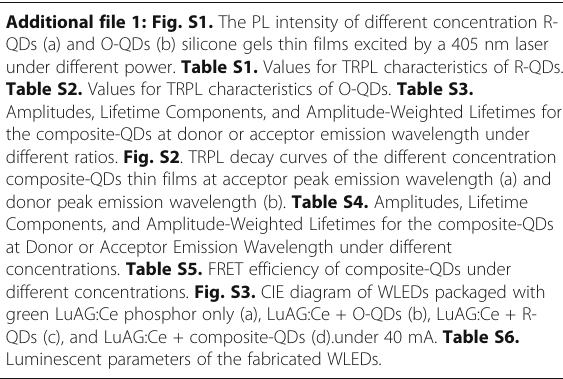
Additional file 1: Fig. S1. The PL intensity of different concentration R- QDs (a) and O-QDs (b) silicone gels thin films excited by a 405 nm laser under different power. Table S1. Values for TRPL characteristics of R-QDs. Table S2. Values for TRPL characteristics of O-QDs. Table S3. Amplitudes, Lifetime Components, and Amplitude-Weighted Lifetimes for the composite-QDs at donor or acceptor emission wavelength under different ratios. Fig. S2 . TRPL decay curves of the different concentration composite-QDs thin films at acceptor peak emission wavelength (a) and donor peak emission wavelength (b). Table S4. Amplitudes, Lifetime Components, and Amplitude-Weighted Lifetimes for the composite-QDs at Donor or Acceptor Emission Wavelength under different concentrations. Table S5. FRET efficiency of composite-QDs under different concentrations. Fig. S3. CIE diagram of WLEDs packaged with green LuAG:Ce phosphor only (a), LuAG:Ce + O-QDs (b), LuAG:Ce + R- QDs (c), and LuAG:Ce + composite-QDs (d).under 40 mA. Table S6. Luminescent parameters of the fabricated WLEDs.